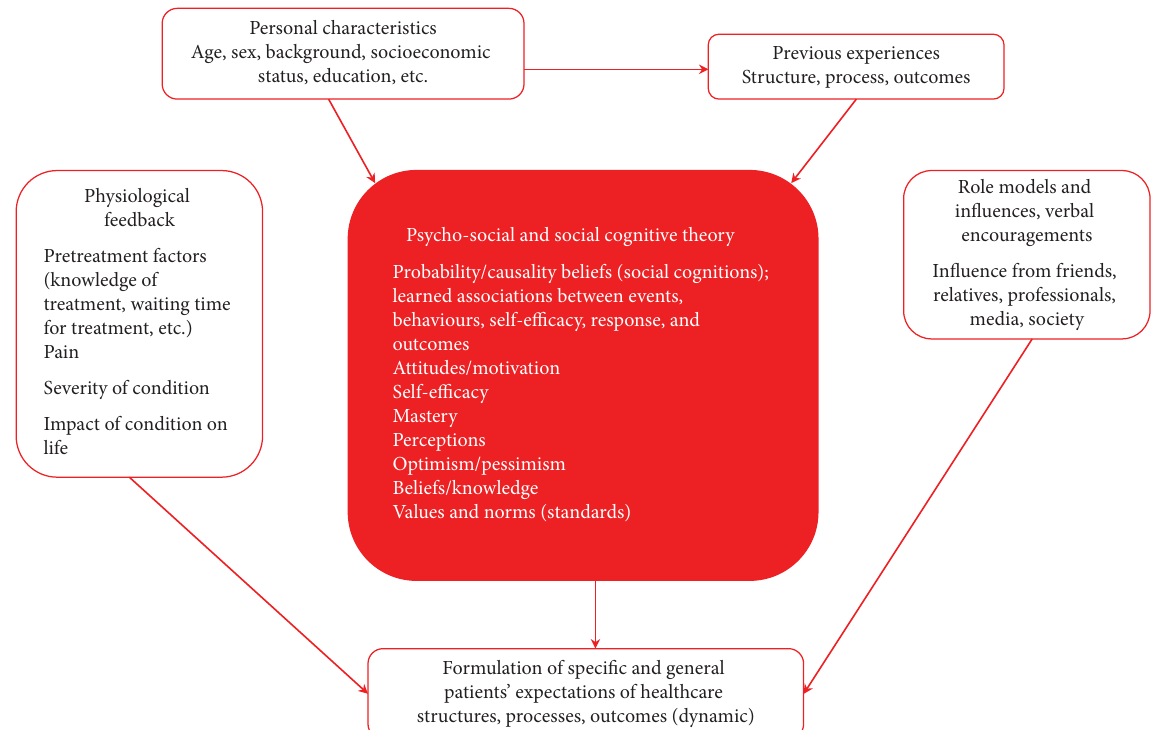
Figure 4: Model based on the literature of multiple influences on patients’ healthcare expectations (adapted from Bowling 2012